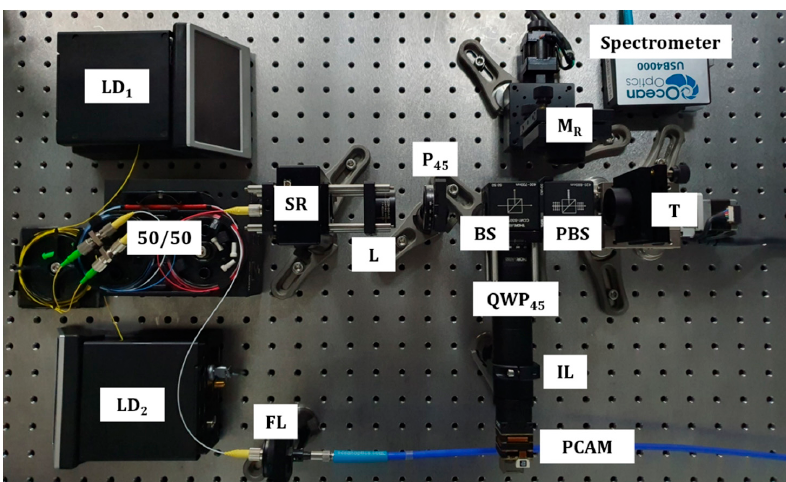
Figure 3. Photographs of the proposed system; LD, fiber Bragg grating laser diode, SR, speckle reducer; L, lens; P 45 , 45° rotated polarizer; BS, beam splitter; PBS, polarizing beam splitter; QWP 45 , 45° rotated quarter waveplate; IL, imaging lens; FL, focusing lens; M R , reference mirror; T, target; PCAM, polarization- pixelated camera.